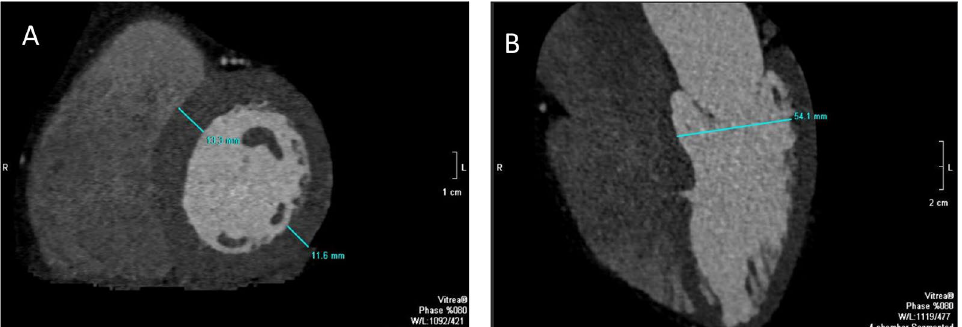
Fig. 2 Measurement of the LV wall thickness (both the septum and posterior wall) in the short axis at the level of the chordea ( A ) and the left ventricle end-diastolic inner diameter in the four-chamber view ( B